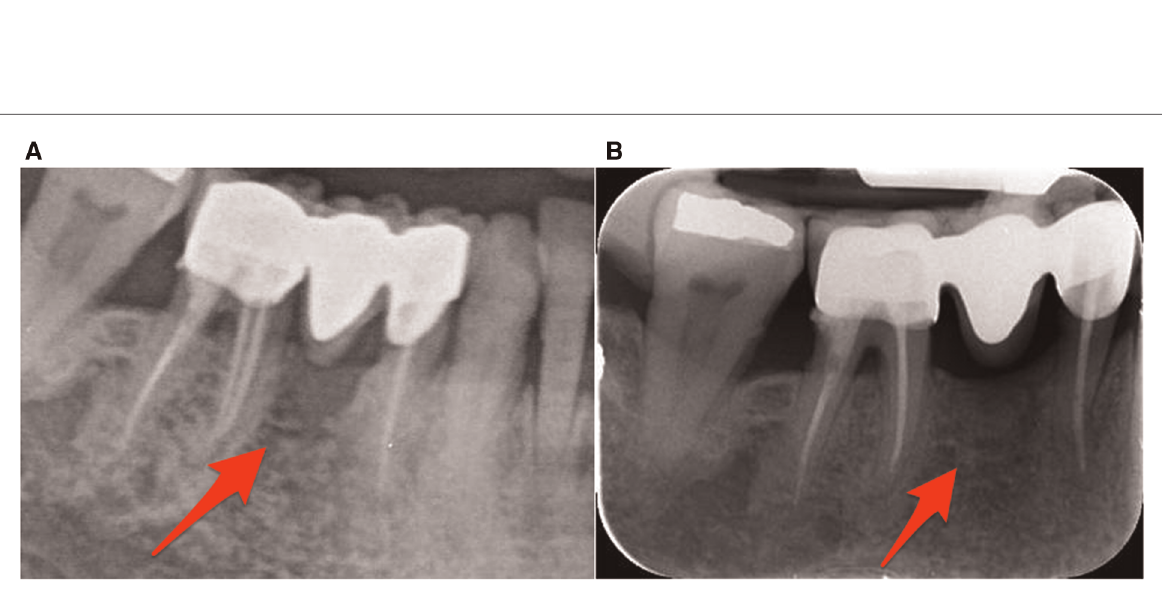
FIGURE 2 Radiographic image of the lower right premolar-molar region. ( A ) Radiographic image during patient ’ s initial visit. ( B ) Radiographic image taken 6 months later revealing bone